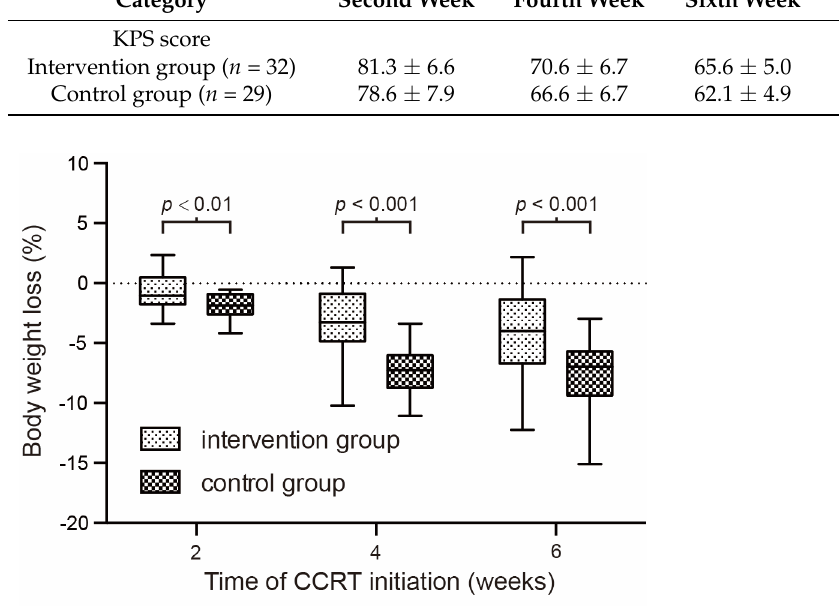
Table 4. Comparison of KPS between the two groups (Mean ± SD); Abbreviation: KPS, Karnofsky Performance Status.